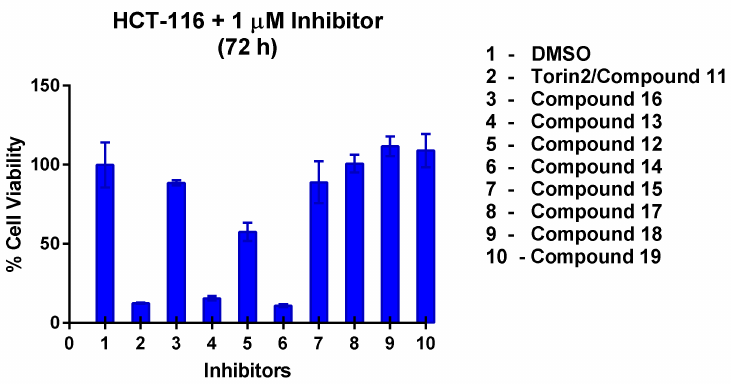
Figure 7. HCT-116 cell line was treated with synthesized compounds at 1 µ M for 72 h. Compounds 13 and 14 showed good potency similar to Torin2/compound 11